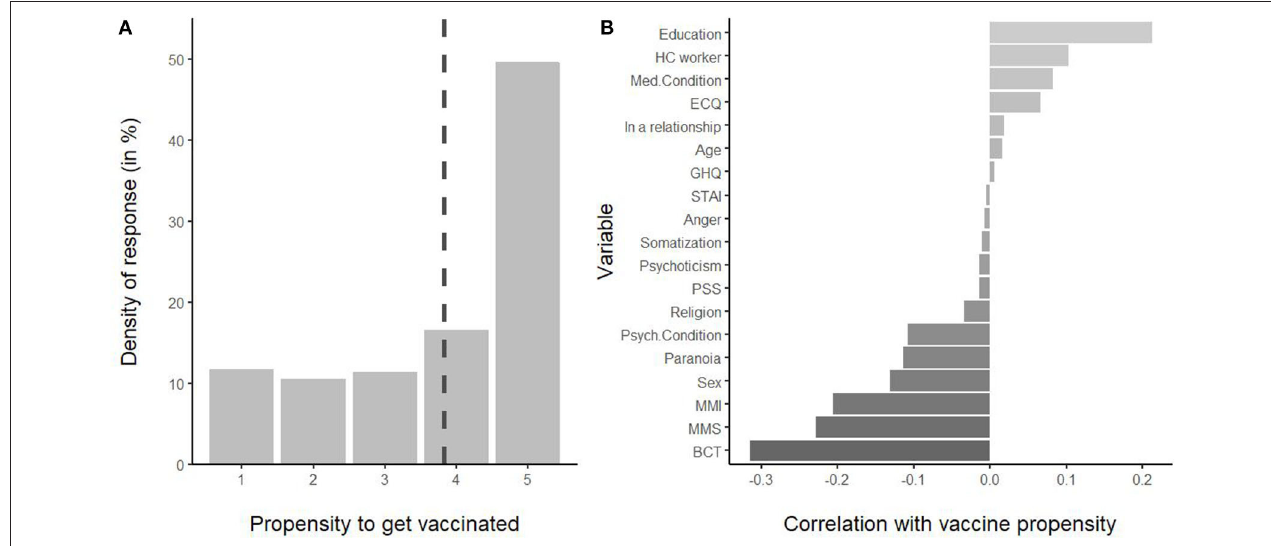
FIGURE 1 | (A) Distribution of responses for the vaccine propensity. The dashed line indicates the mean. (B) Correlation coefficients of vaccine propensity with demographic and psychological variables, ordered by coefficient. HC worker, healthcare worker; BCT, belief in conspiracy theories; MMI, mistrust in medical information; MMS, mistrust in medicine and